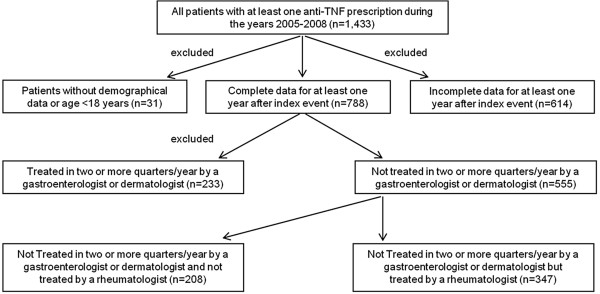
Study population.